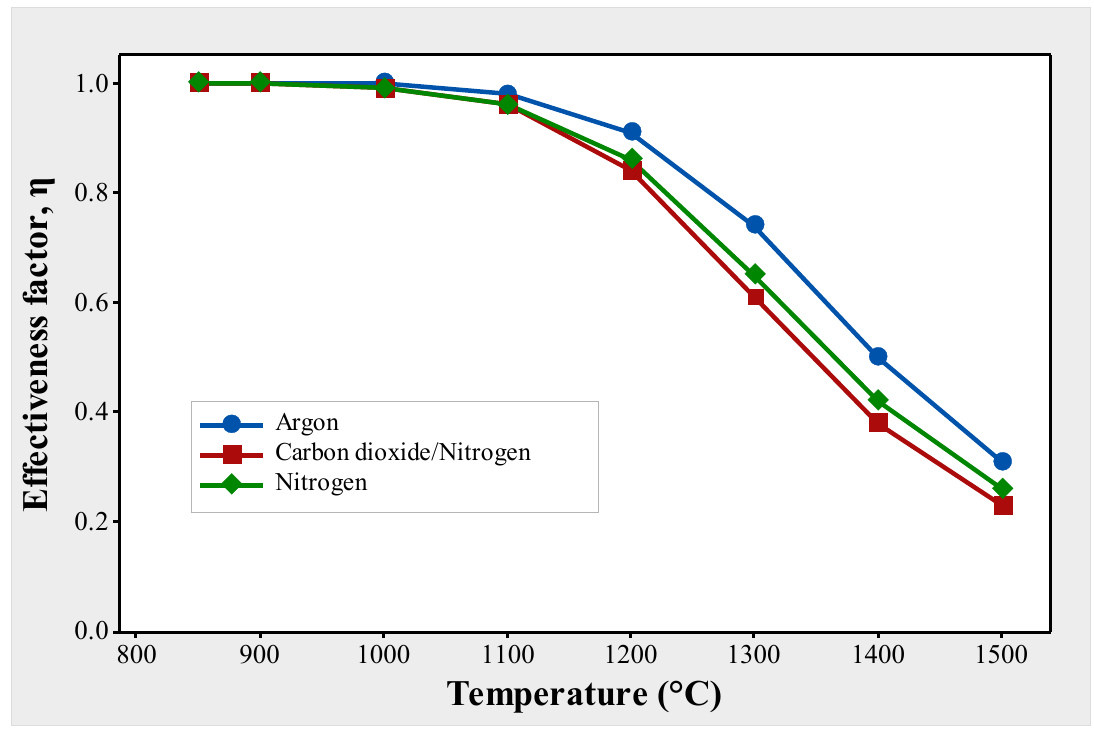
Figure 14 . Effectiveness factor for char-CO 2 reaction at 6.2 bar. Figure 14. Effectiveness factor for char-CO